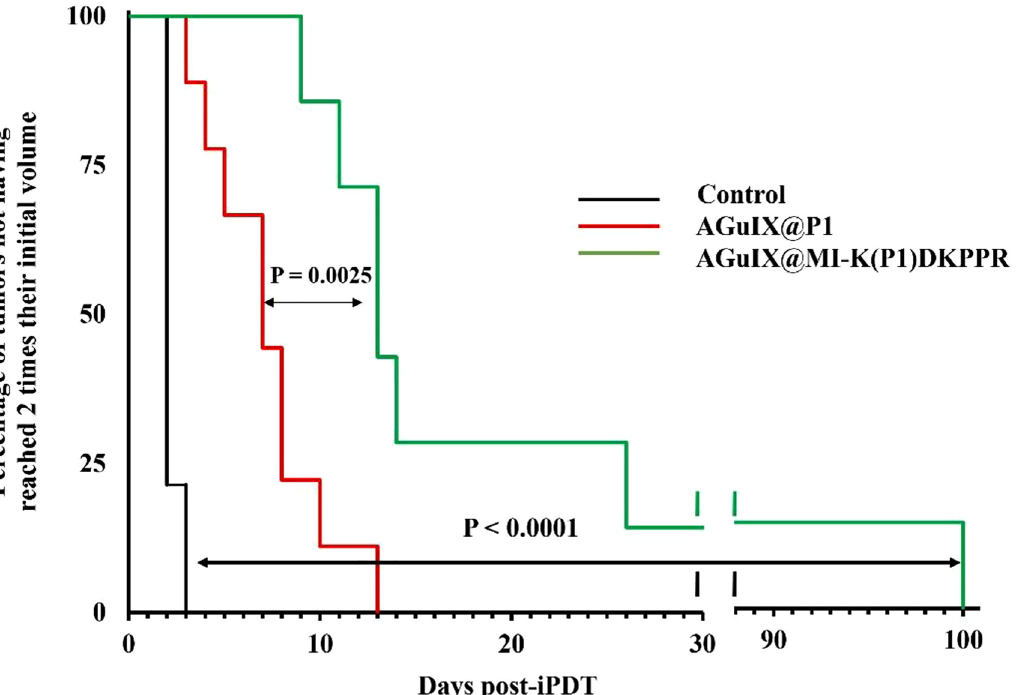
Figure 6: Kaplan – Meier curves of control rats or rats treated by iPDT using AGuIX@P1 NPs (in red) or AGuIX@MI-K(P1)DKPPR (in green), considering the percentage of tumors not having reached two times their initial volume at the end point. At least seven animals were used for each experimental group. Statistical analysis was performed using the Log rank test and highlighted a statistically significantly difference between AGuIX@MI-K(P1)DKPPR group and control group ( P < 0.0001) and between AGuIX@P1 ( P = 0.0025). Adapted from Gries et al.